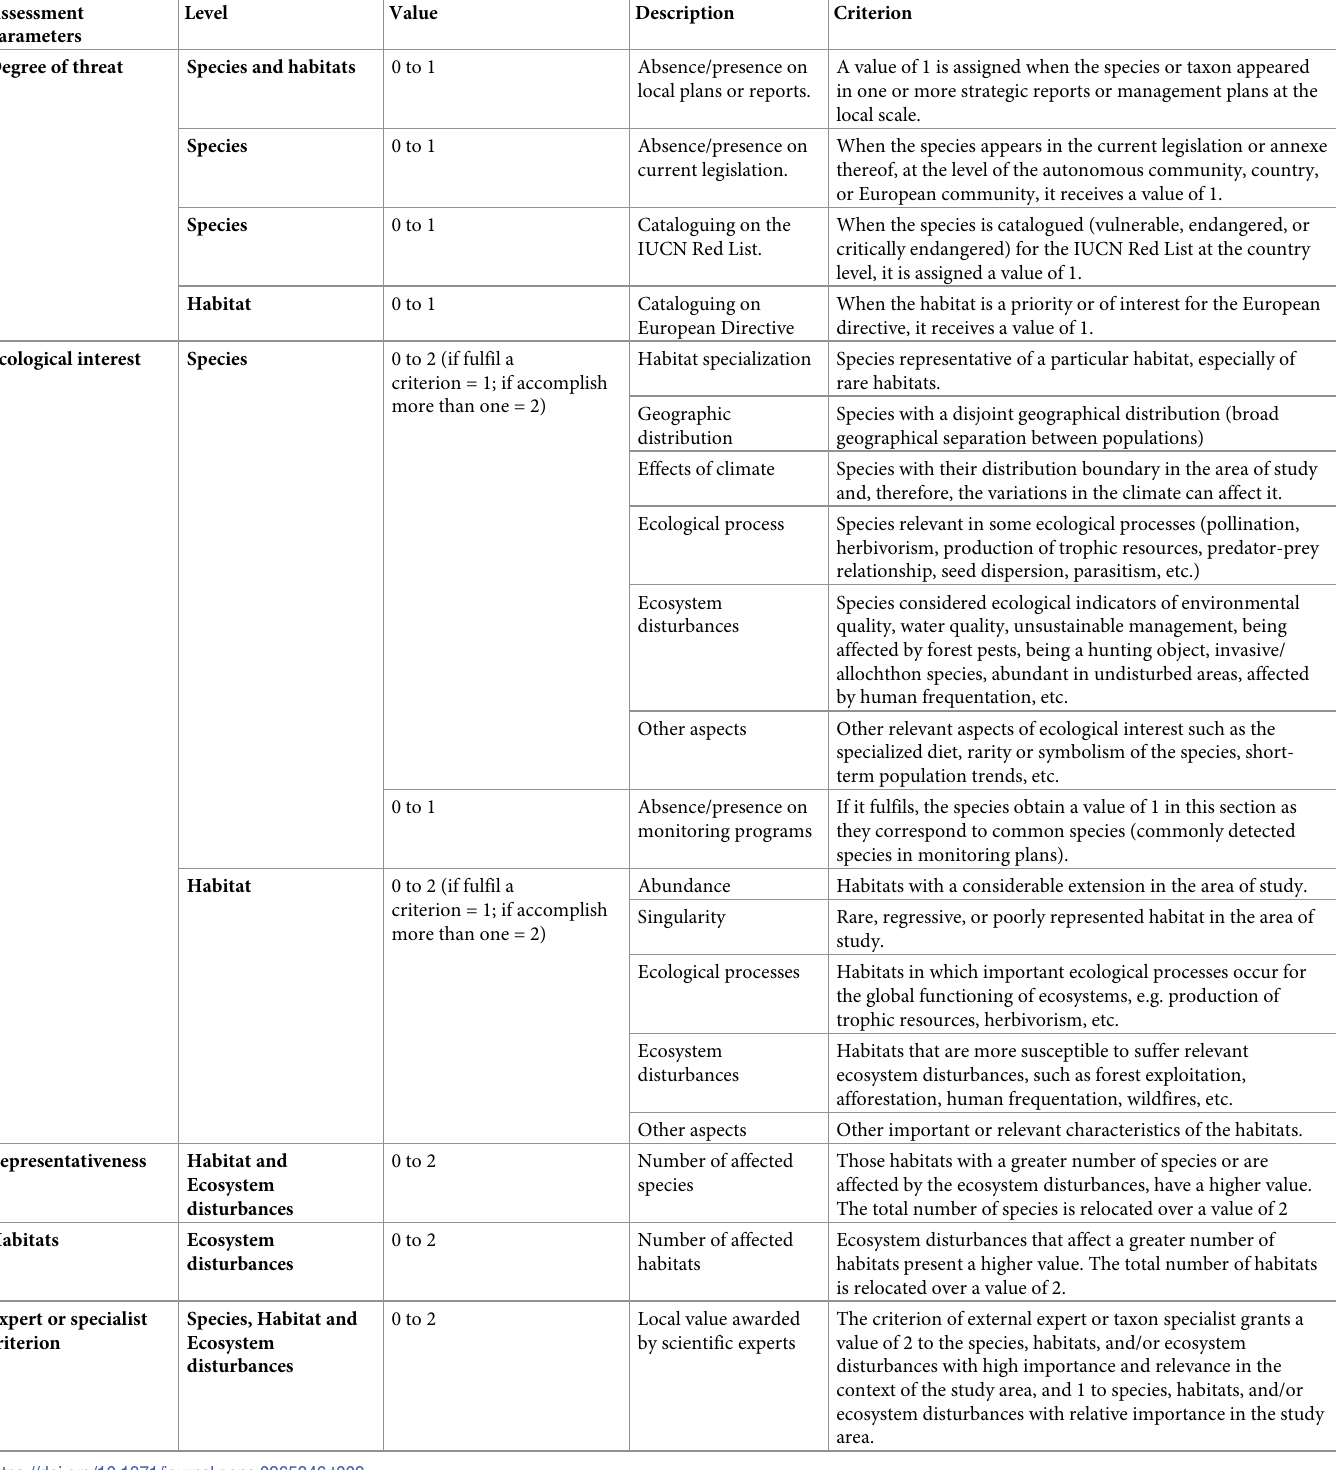
Table 2. Summary of the assessment parameters used to select the relevant candidates, the ecological level (species, habitat, or ecosystem disturbances), the valua- tion for the calculation of the relevance index, the parameter’s description, and the specific criterion to assess each of the